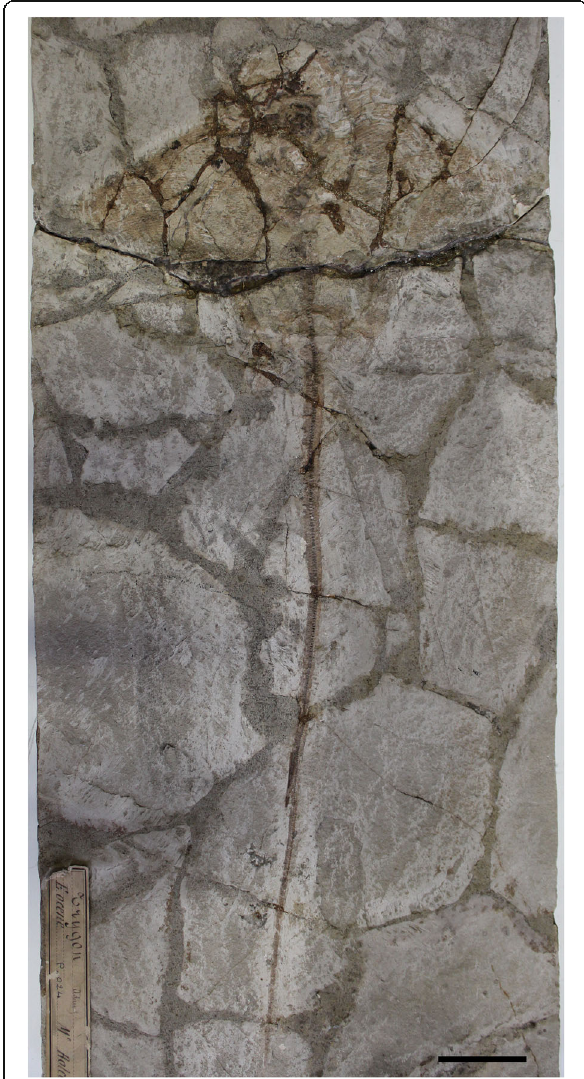
Fig. 2 Promyliobatis gazolai from the Eocene of the Bolca Lagerstätte. MSNPV 14620. Scale bar = 50